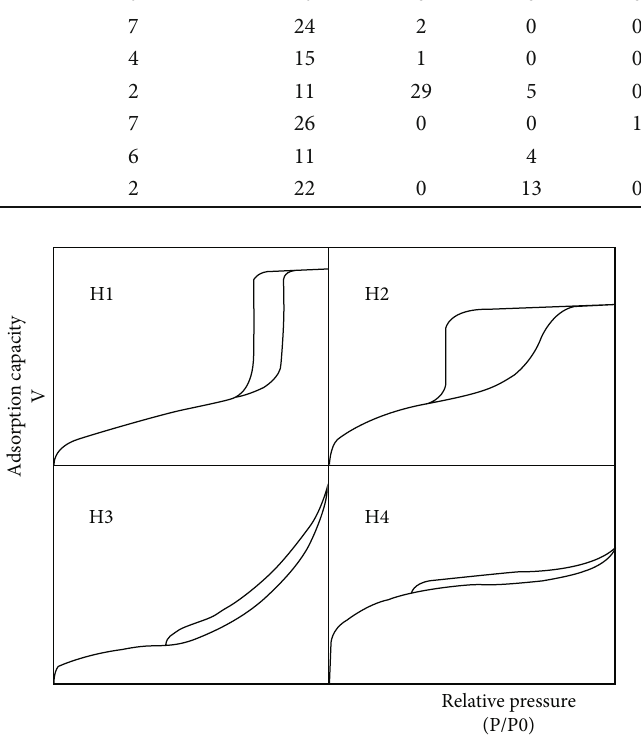
Figure 4: Hysteresis loops recommended by the International Union of Pure and Applied Chemistry.